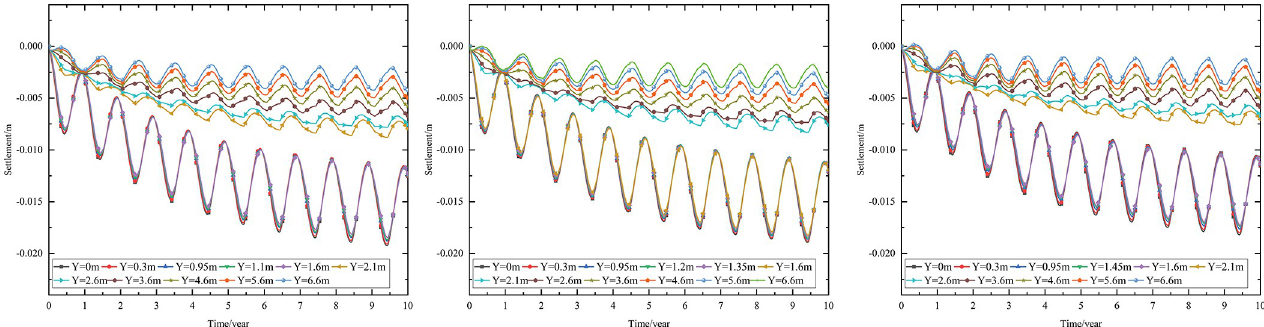
Fig 15. Settlement-time curves of pavement center with the installation layer at (a) the top of the subbase layer, (b) the middle of the subbase layer, and (c) the bottom of the subbase layer.